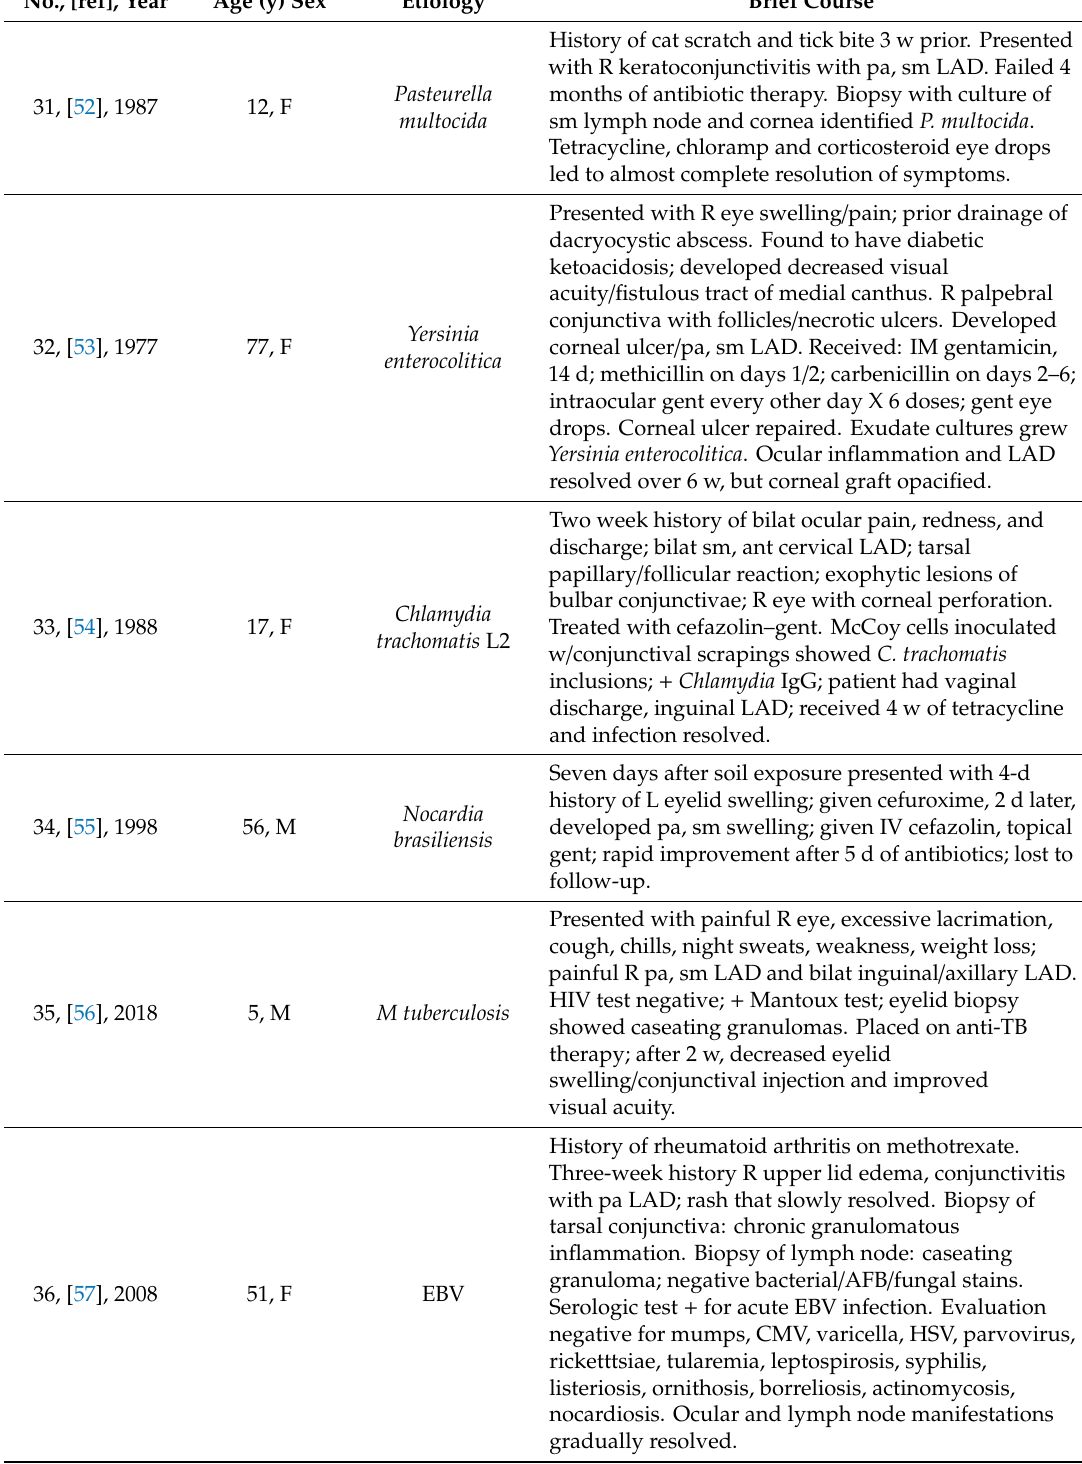
Table 6. Parinaud’s oculoglandular syndrome in miscellaneous bacterial, fungal, and viral infections. No., [ref],